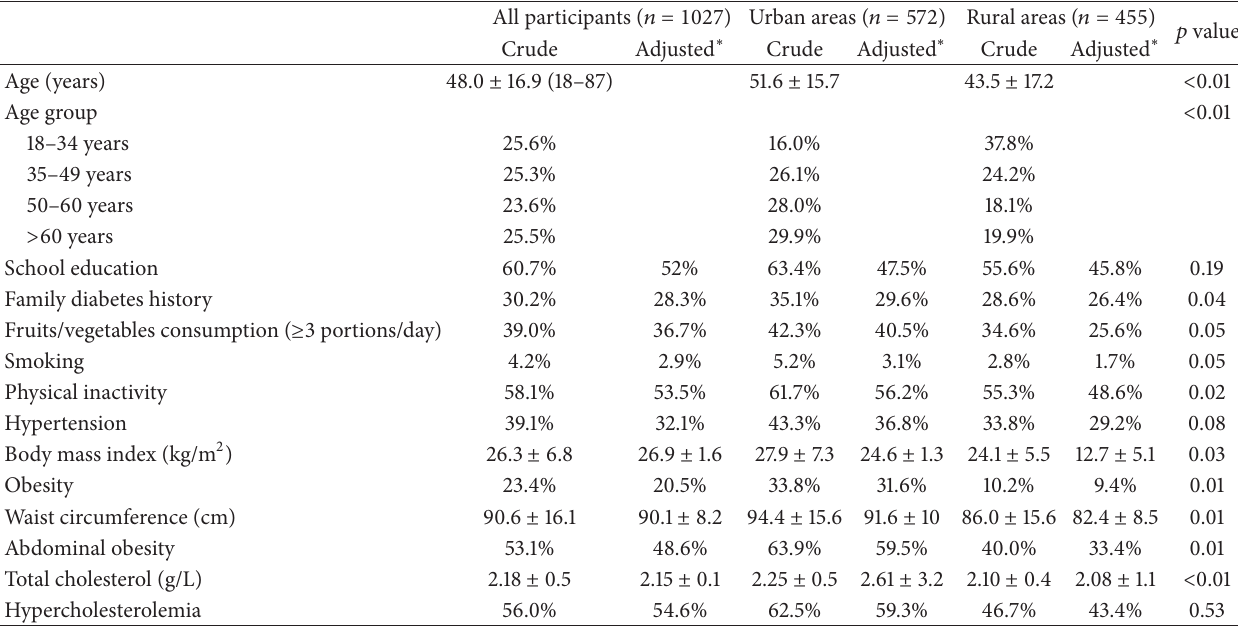
Table 1: Clinical and biochemical characteristics of participants.